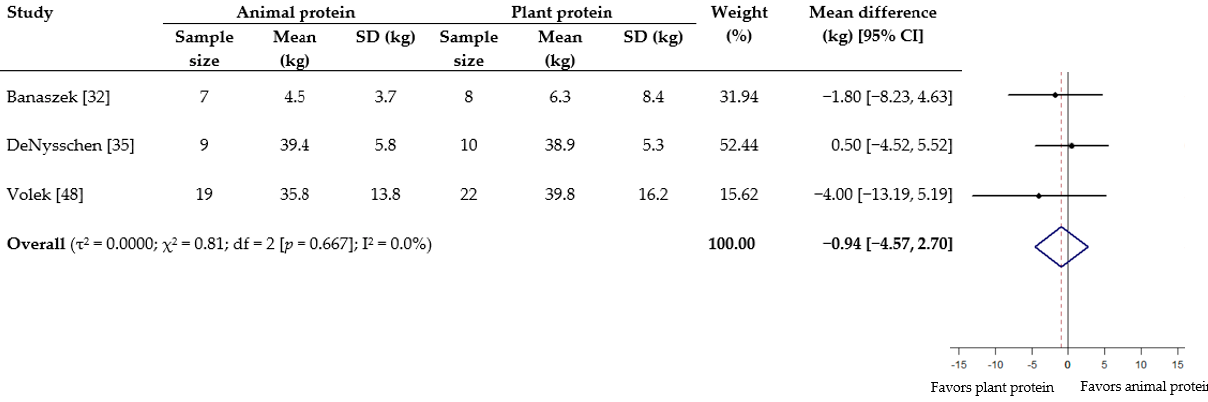
Figure 4. Effect of consuming animal protein compared to plant protein on changes in 1-RM squat (kg). Data expressed as weighted mean differences with 95% CIs, using a random-effects model. 1-RM: one-repetition maximum.